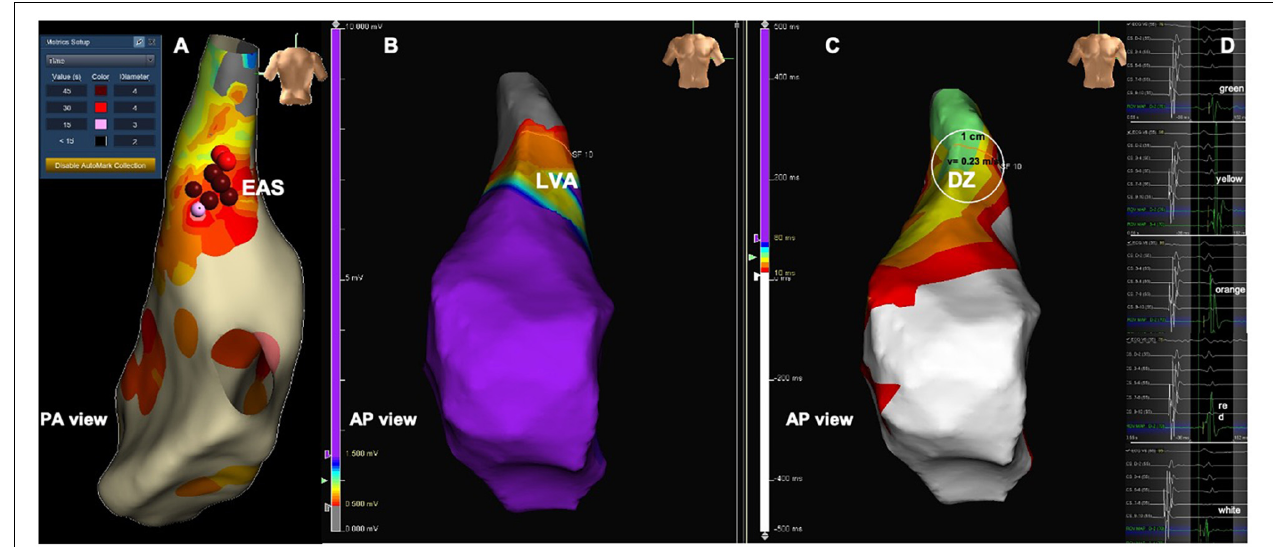
FIGURE 8 | Patient from the PVC group with DZ at a LVA but the earliest activation site located outside the DZ. (A) Activation map during PVC showing the EAS in the RVOT posterior wall. (B) Voltage map in sinus rhythm with LVA in the RVOT anterior wall. (C) RVOT isochronal map in sinus rhythm with DZ in the RVOT anterior wall. (D) Intracardiac electrograms corresponding to the respective isochrones presented in the isochronal map. Red and pink balls in (A) corresponding to radiofrequency application points. DZ, deceleration zone; EAS, earliest activation site; LVA, low voltage area; PVC, premature ventricular contractions; RVOT, right ventricular outflow tract.